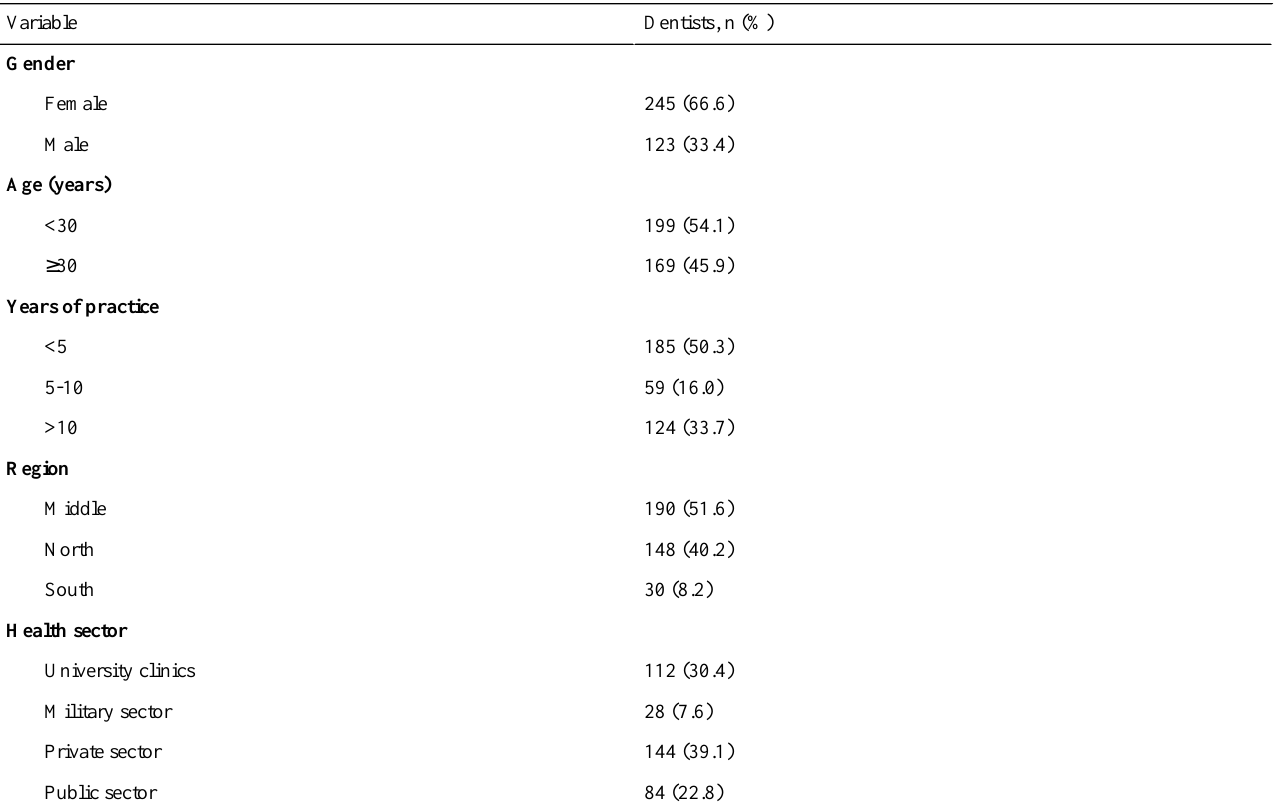
Table 1. The characteristics of the 368 dentists enrolled in the study.